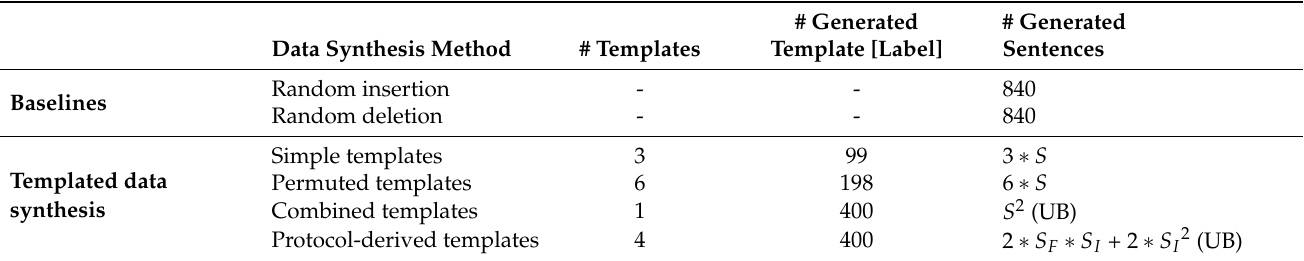
Table 3. Summary statistics for the synthetic datasets used in this work. For the templates, the number of generated sentences depends on the total number of synonyms S , the number of finding synonyms S F and the number of impression synonyms S I . For the compound templates (combined, protocol-based), the number of generated sentences further depends on the template[label] combinations that are samples; here, we indicate the upper bound